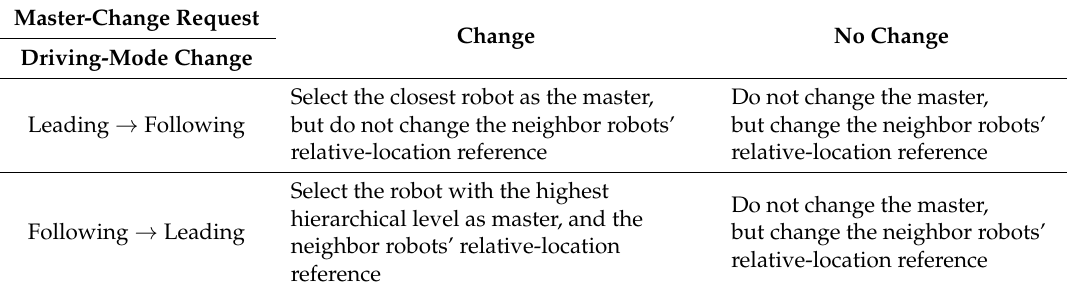
Table 3. Criteria for changing the master when the driving mode is changed.